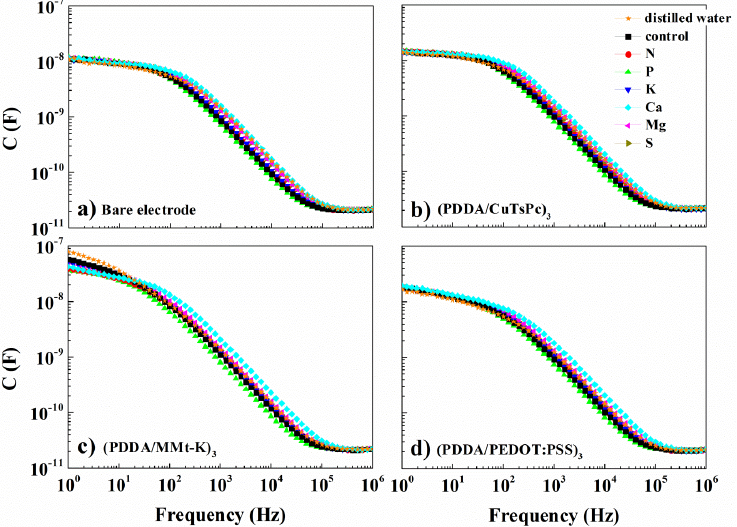
Figure 2. Capacitance versus frequency spectra obtained for seven soil samples (control, N, P, K, Ca, Mg, and S) in aqueous solutions using ( a ) bare electrode; ( b ) (PDDA/CuTsPc) 3 ; ( c ) (PDDA/MMt-K) 3 and ( d ) (PDDA/PEDOT:PSS) 3 sensing units. Note that the capacitance for the control sample was C 0 in Figure